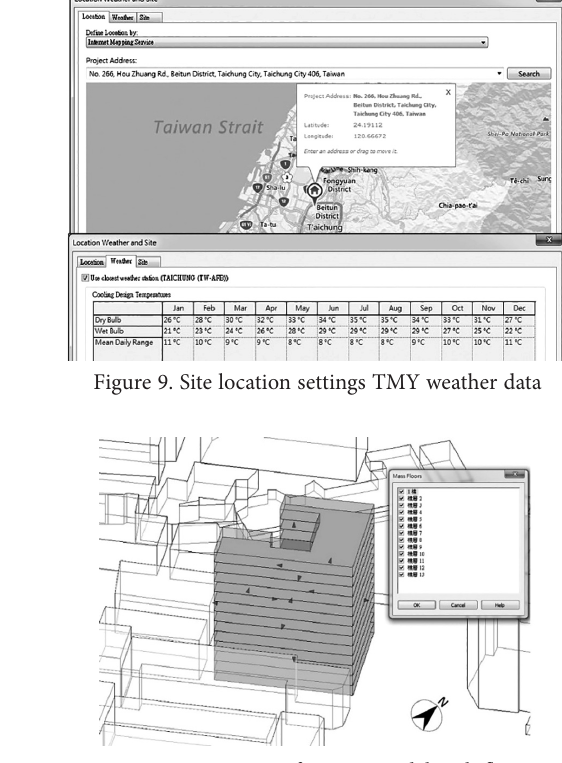
Figure 10. Creation of a mass model with floors (geometric information)